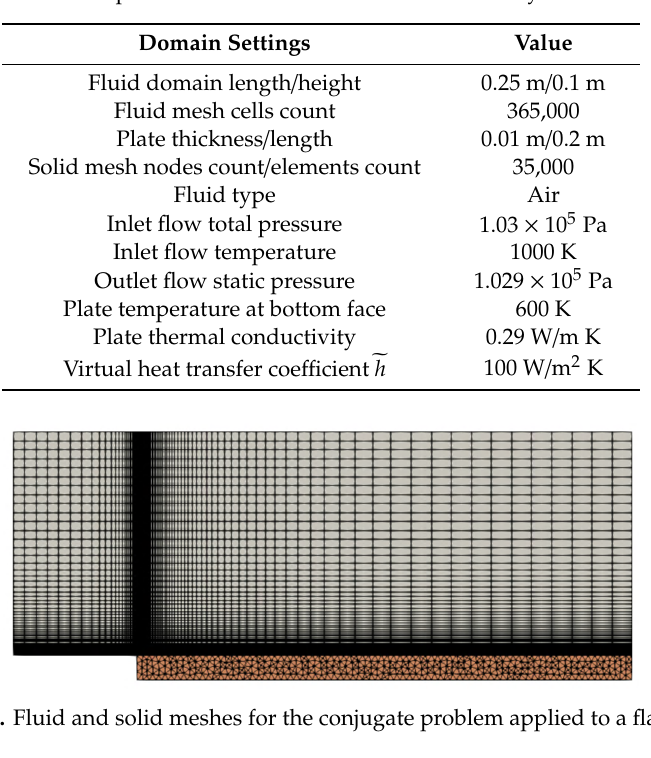
Table 1. Flat plate domain characteristics and boundary conditions.